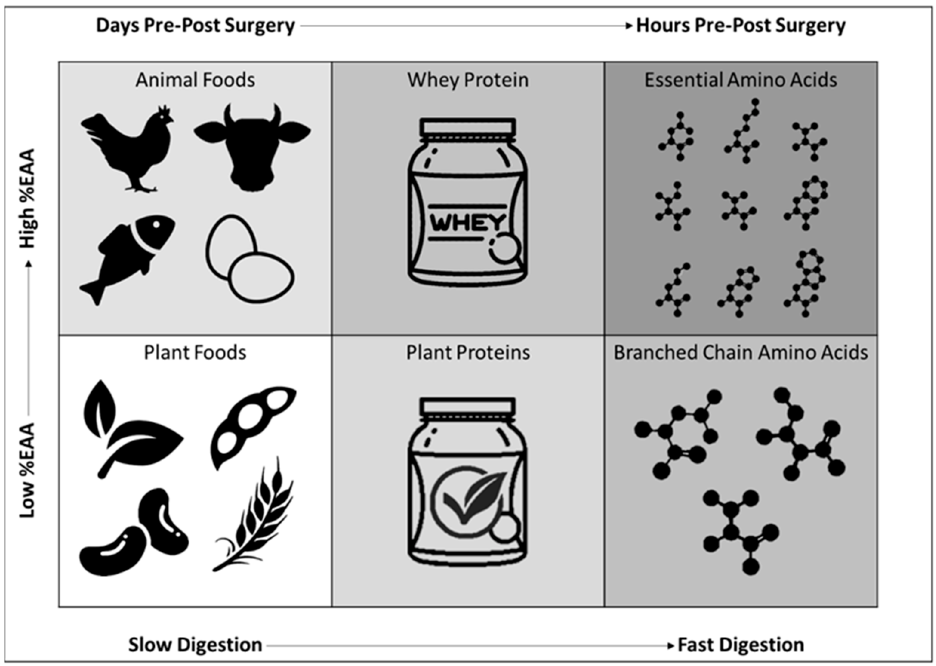
Figure 2. Protein sources with consideration of food source, protein quality, absorption, and EAA availability. EAA